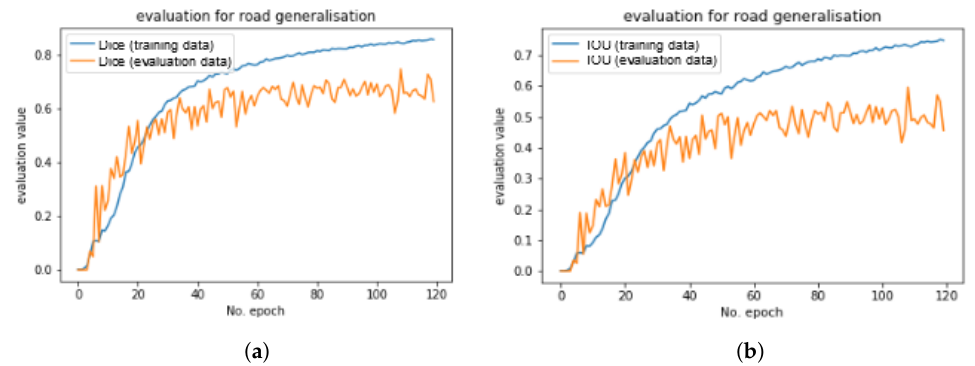
Figure 9. Evolution of the evaluation value across epochs. ( a ) With Dice measure. ( b ) With intersection over union (IOU)